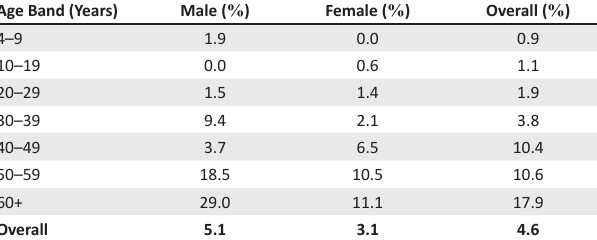
TABLE 2: Proportion of persons with disabling hearing ( % ) loss by gender and age categories. Age Band (Years)